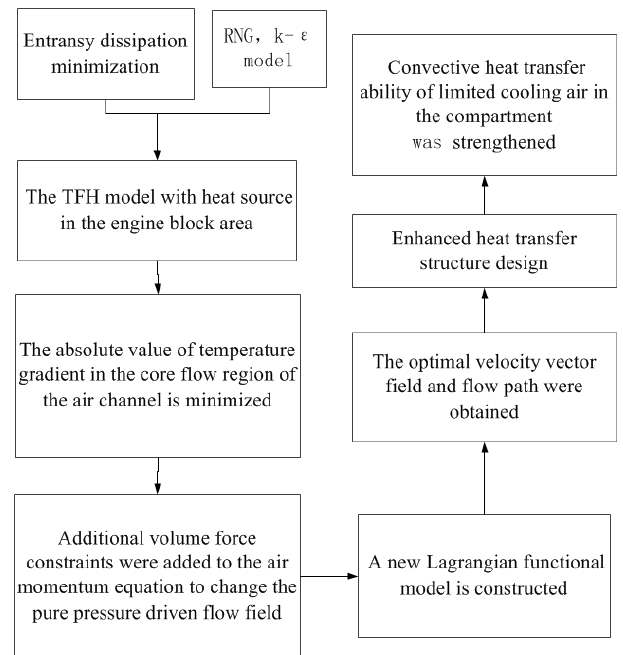
Figure 3. The idea of